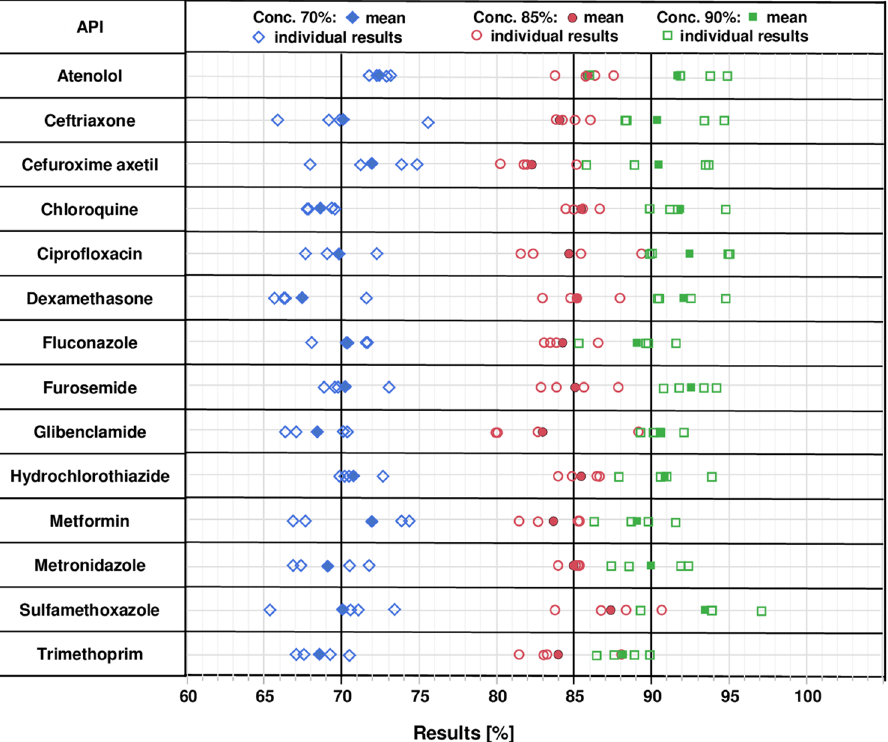
Figure 3. Individual and mean (n = 4) results of the quantitative determination of 14 active pharmaceutical ingredients with the TLCyzer app. For each API, three test solutions containing 70%, 85% and 90% of the standard concentration given in Table 1 were prepared and analysed four times by TLC and image analysis (see “Methods”). These results are further evaluated in Table 2, and the numerical values of all individual measurements are listed in Supplementary Table